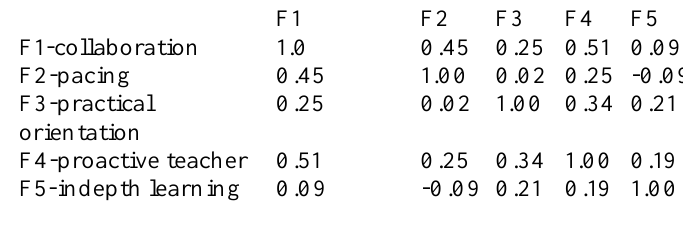
Pearson Correlation Coefficients Between the Factors